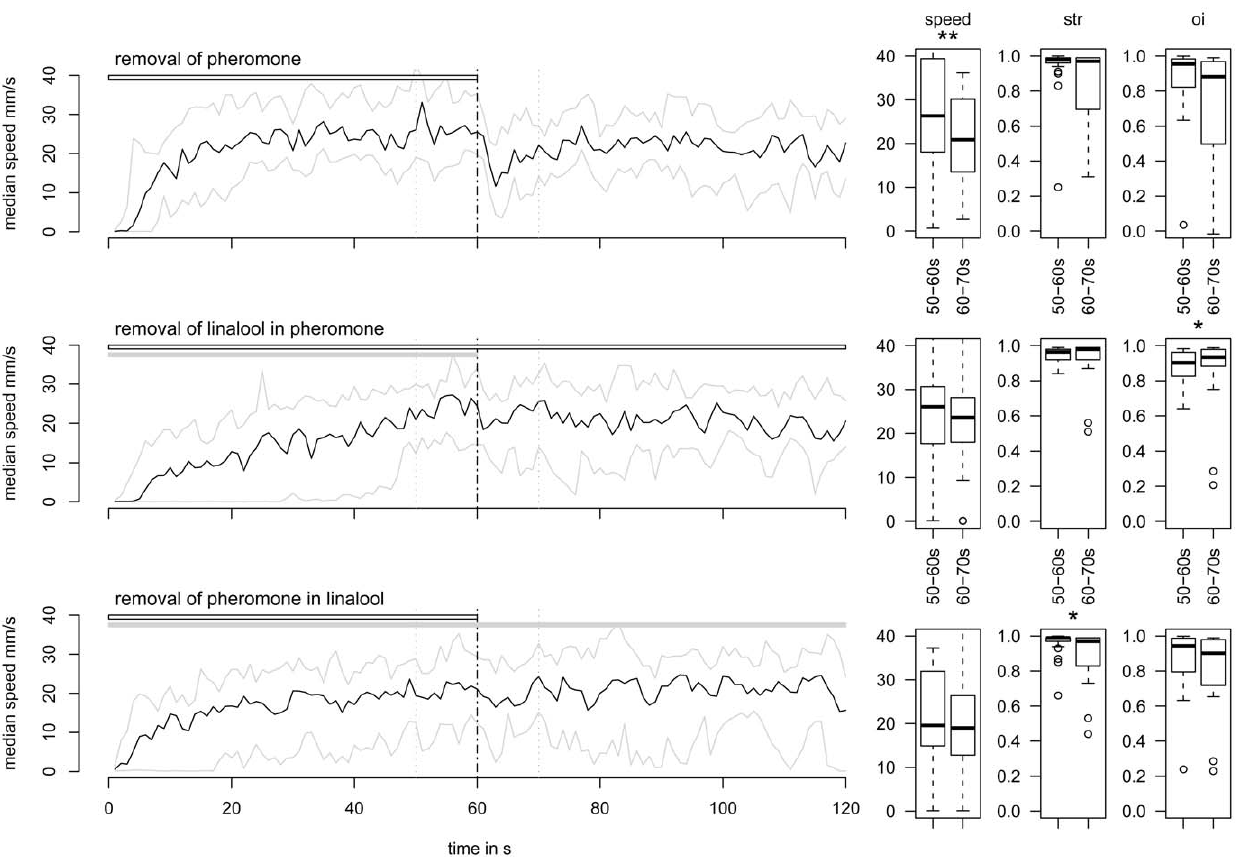
Figure 7. Lin could act as secondary cue to maintain the orientation after loss of odor. On the left: time plots of the evolution of speed during two-phase experiments (median in black; first and third quartiles in grey). The horizontal bars show PV (grey) and pheromone (white) presentations. The vertical grey dashed lines delimit the 10-s time windows before and after the loss of Phero in a neutral background ( N =24), the loss of Phero in a Lin background ( N =26) or the loss of Lin during Phero presentation ( N =24), and chosen to calculate and compare the median speeds, straightness (str) and orientation index (oi) presented in the corresponding box plots (Right). Box plot legends as in Figure 3.